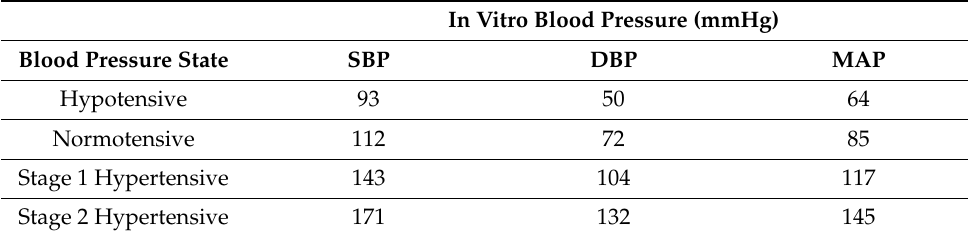
Table 2. Measured pressures in each blood pressure state at the input of the